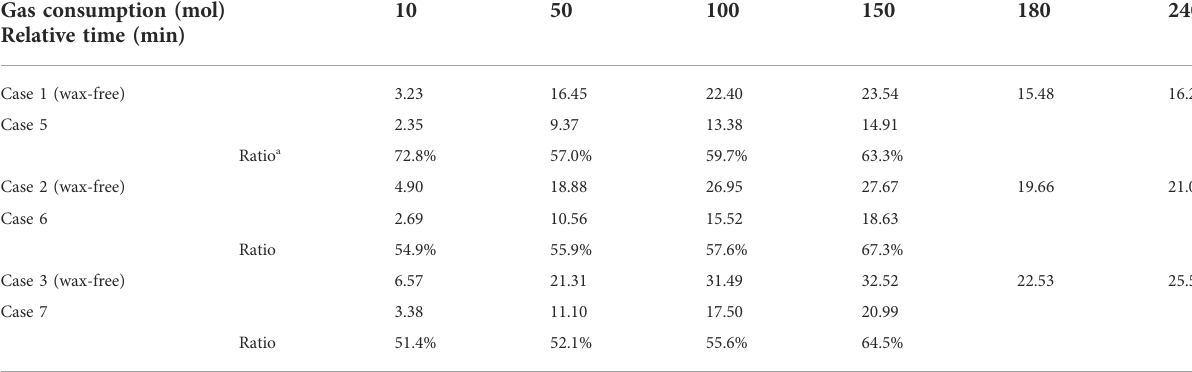
TABLE 4 Comparison of gas consumption of wax-free cases and their corresponding wax-containing cases at different relative